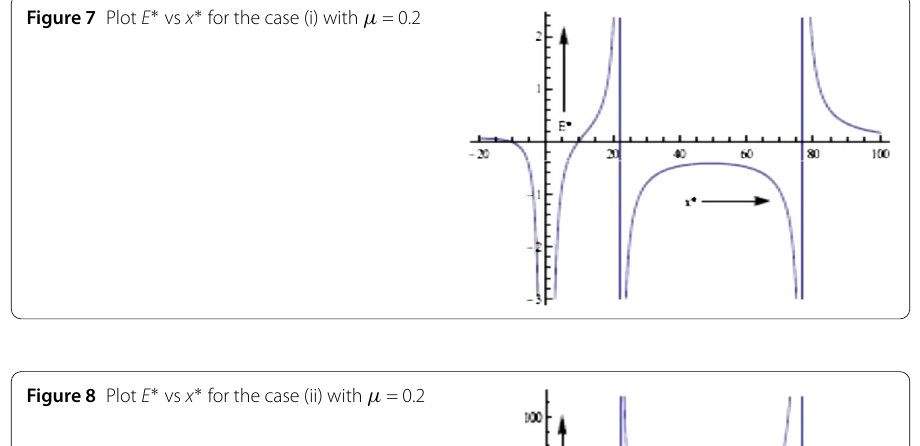
Figure 8 Plot E ∗ vs x ∗ for the case (ii) with μ = 0.2